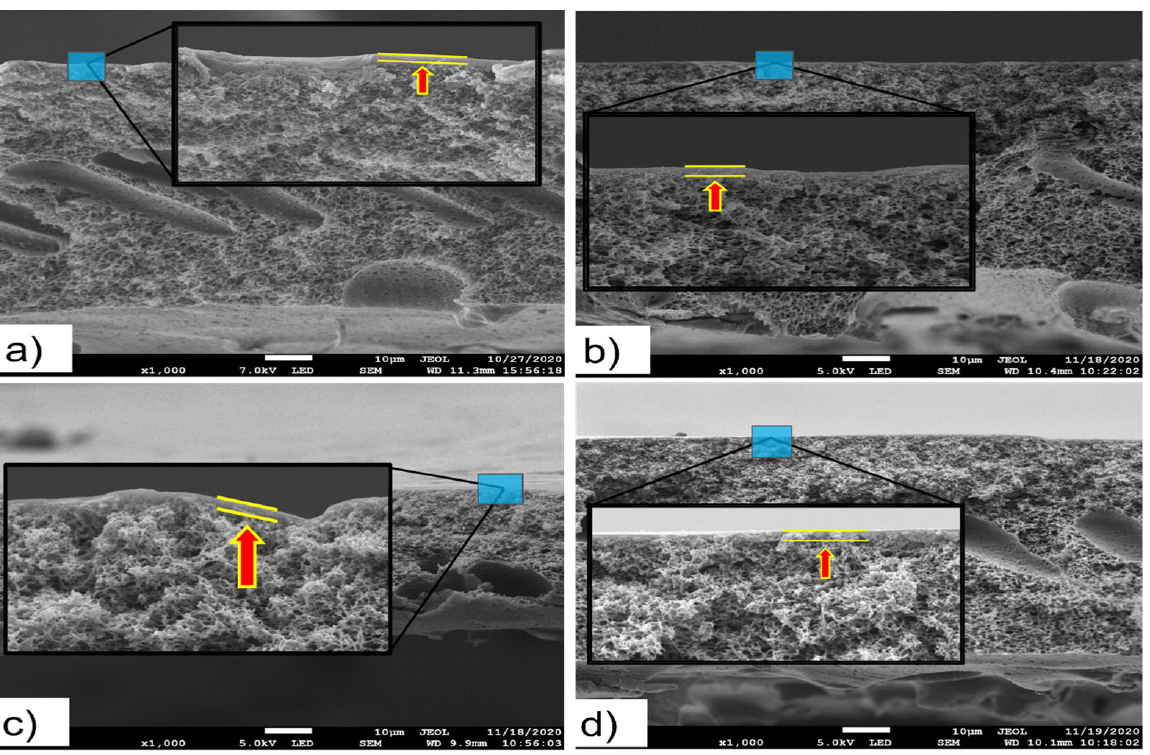
Figure 10. FESEM images (1000× magnification) of the membranes: ( a ) cross section of NF2 PES, ( b ) cross section of 0.5 MAA3, ( c ) cross section of 0.5 MAA5, ( d ) cross section of 0.5 MAA10, ( e ) top surface of NF2 PES, ( f ) top surface of 0.5 MAA3, ( g ) top surface of 0.5 MAA5 and ( h ) top surface of 0.5 MAA10.